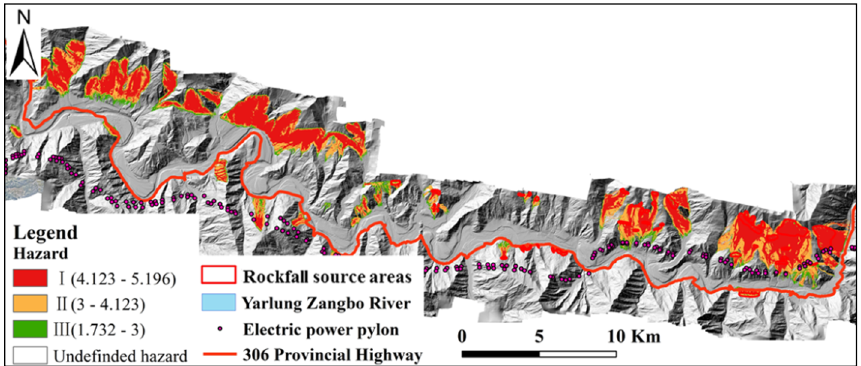
Figure 9. Hazard assessment map of study area.